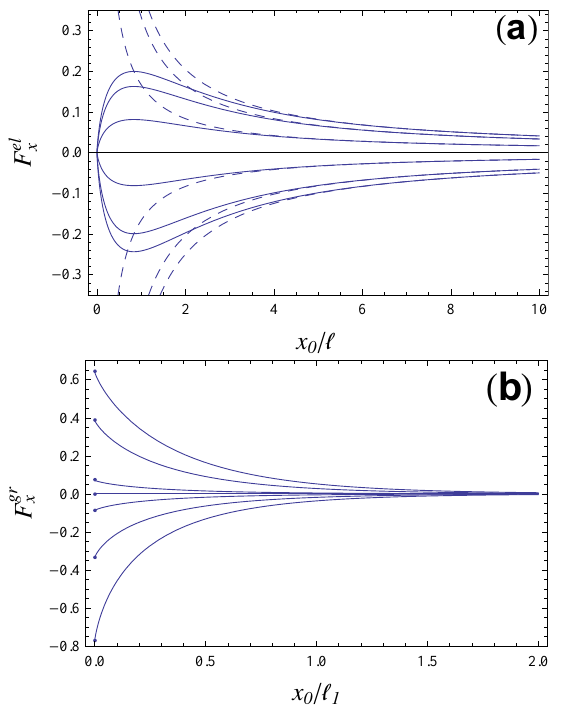
Figure 6: Dependence of the image forces (a) F el x and (b) F gr x on the normalized positions, (a) x and (b) x , of a screw dislocation 0 / (cid:96) 0 / (cid:96) 1 near (a) a purely elastic interface for (cid:96) and = 10, 5, 2, 0.5, 1 = (cid:96) 2 = (cid:96) 0.1, and 0 (from top to bottom); (b) a purely gradient interface with µ 2 = µ 1 and (cid:96) 2 / (cid:96) 1 = 10, 2, 1.1, 1, 0.9, 0.7 and 0.5. The force values are given in units of (a) µ 2 /(2 π (cid:96) ) and (b) . The dashed curves in 1 b (a) correspond to the classical